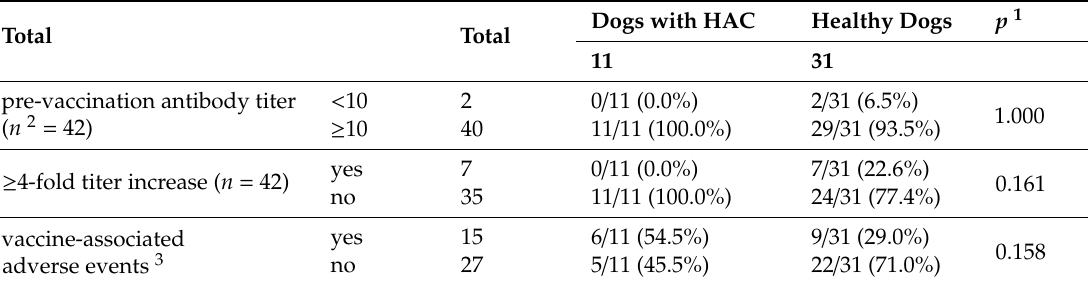
Table 2. Comparison of the humoral immune response of dogs with hyperadrenocorticism (HAC) treated with trilostane and healthy dogs after modified live virus vaccination against canine parvovirus using Fisher´s exact